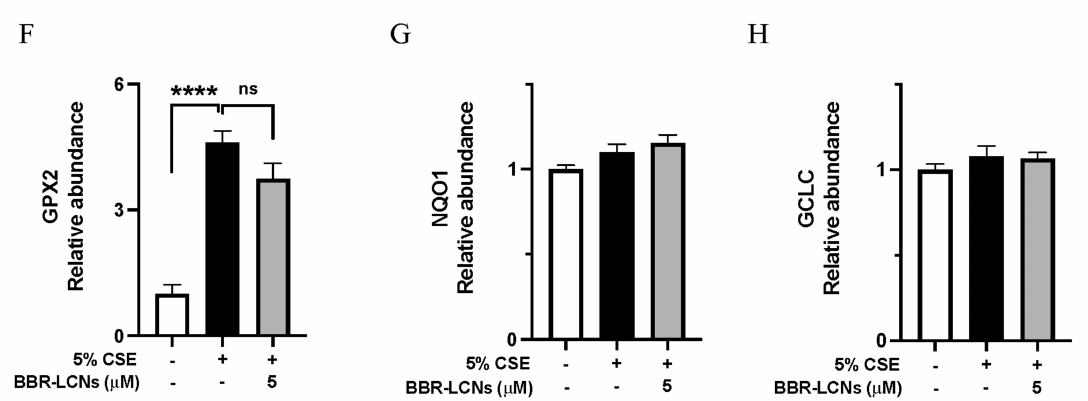
Figure 4. Expression of inflammation-related genes ( A ) IL-1b , ( B ) IL-6 , ( C ) TNF-a , ( D ) 5-LOX , ( E ) PSGT2 , and oxidative-stress-related gene ( F ) GPX2 , ( G ) NQO1 , and ( H ) GCLC expression upon treatment with BBR-LCNs on 16HBE cells. Values are expressed as mean ± SEM ( n = 4–6); * p < 0.05 ** p < 0.01, **** p < 0.0001 (control vs. 5%CSE) and ## p < 0.01, ### p < 0.001 #### p < 0.0001 (5% CSE vs. 5% CSE + BBR-monoolein). ns = not significant. Analysis was performed by a one-way ANOVA followed by Tukey multiple comparison test.